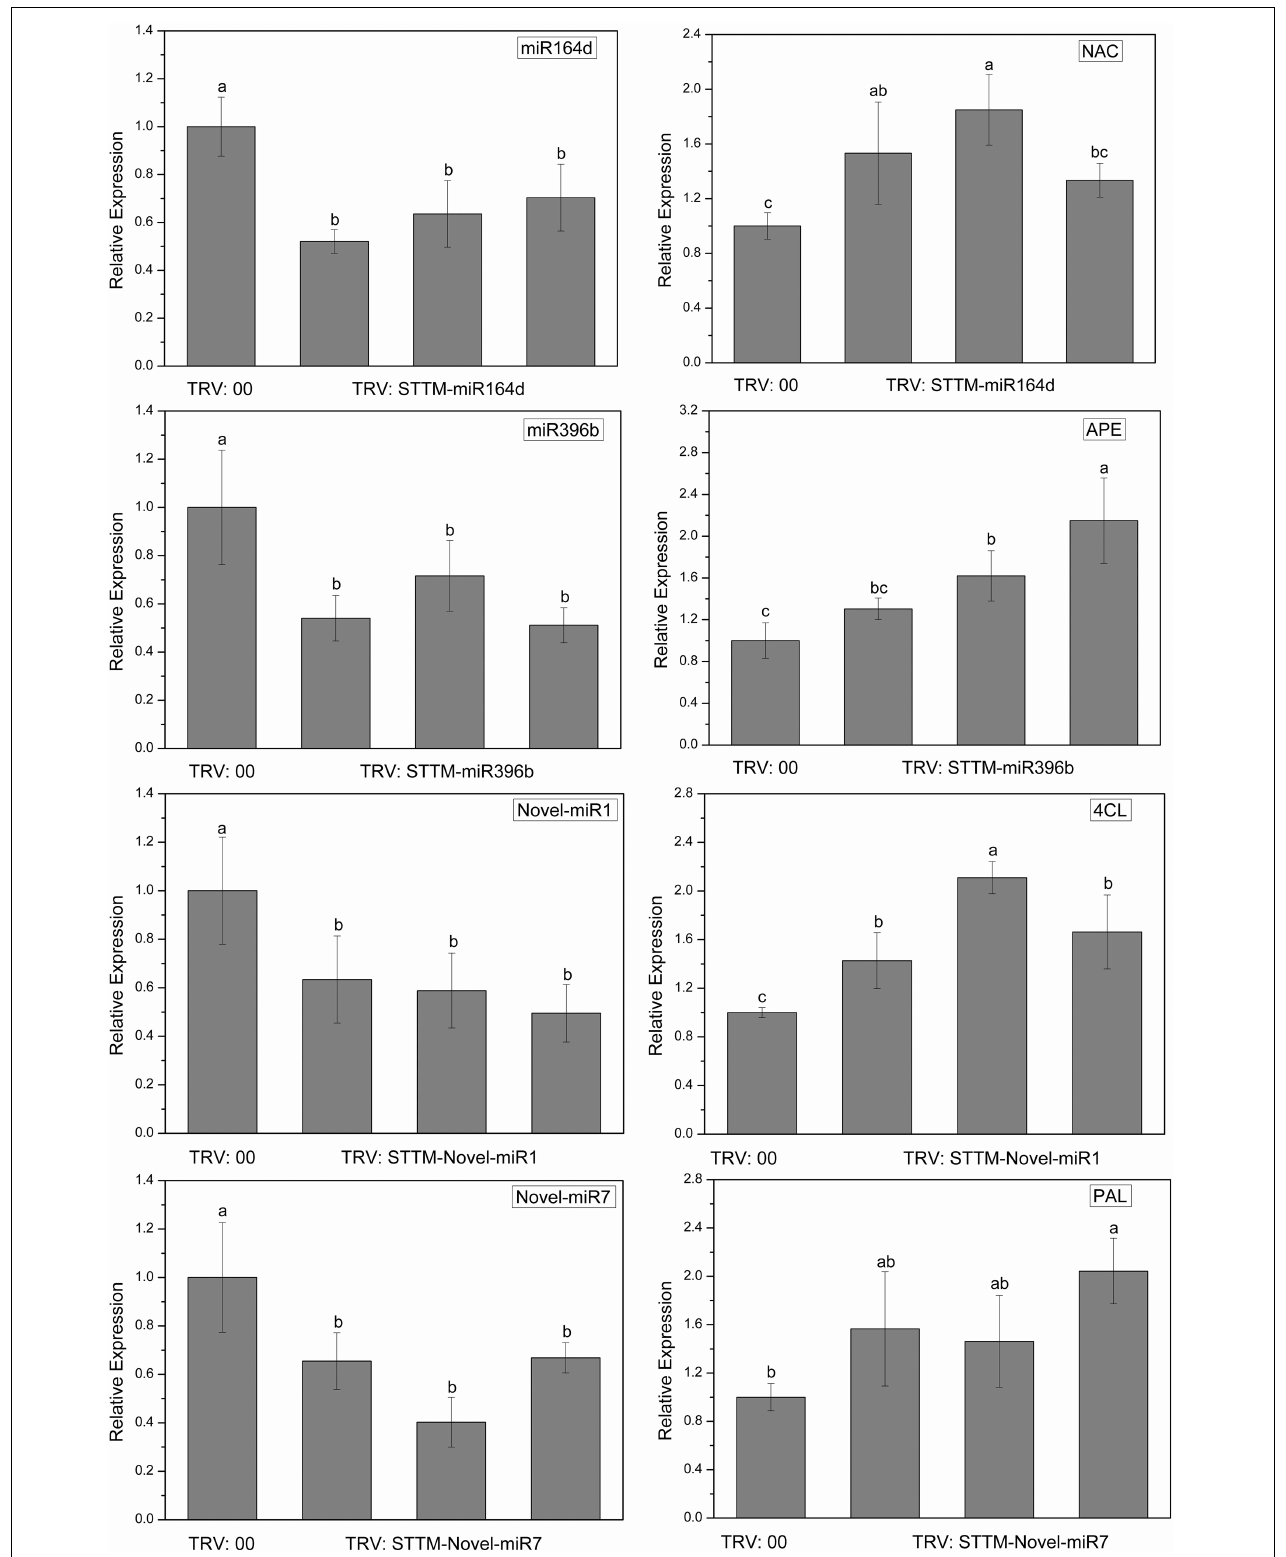
FIGURE 6 | Expression levels of miRNAs and targets in cucumber cotyledons. Significance was determined by Duncan’s multiple range test ( P < 0.05).